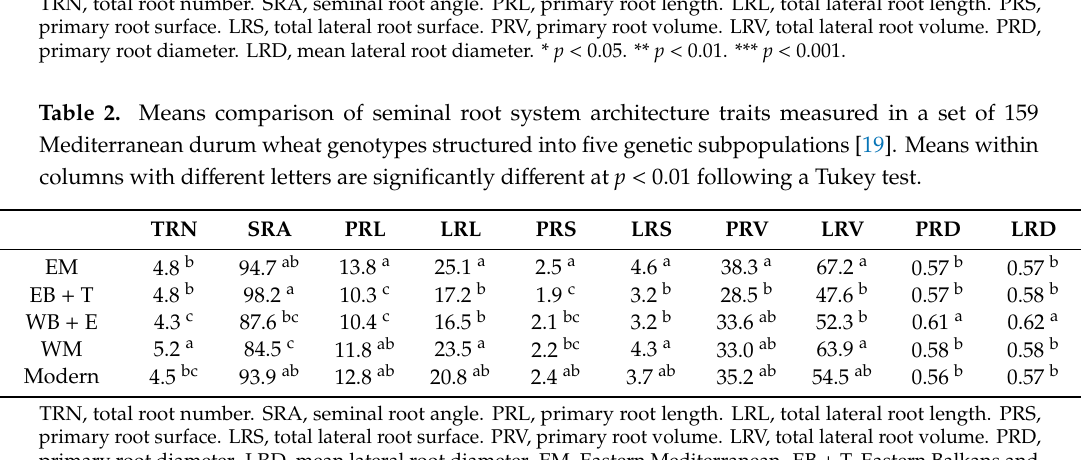
Correlation coe ffi cients between RSA traits and yield-related traits were calculated for two field experiments with contrasting water input (285 and 104 mm of rainfall from sowing to physiological maturity). Whereas, for the rainiest environment, only the relationship between SRA and number of spikes per square meter (NSm 2 ) was statistically significant ( p = 0.043, r 2 = 0.16)). For the driest environment, 14 correlations involving all the yield-related traits and RSA traits except root diameter were statistically significant (Figure 2) ( r 2 between 0.17 for NSm 2 and PRL and PRS to 0.30 for TKW and TRN). Most of the significant correlations were positive. Only the relationship between SRA and thousand kernel weight (TKW) was